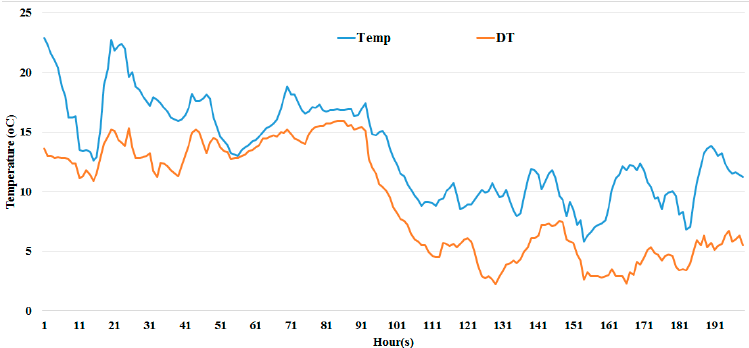
Figure 3. Temperature data information ( ◦ C).